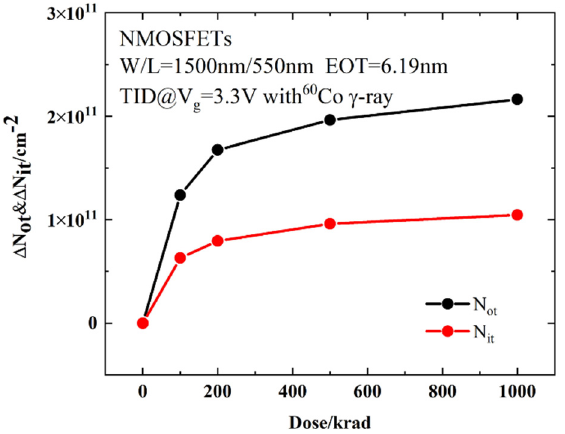
Figure 3. Δ N ot and Δ N it at different doses during radiation. Figure 3. ∆ N ot and ∆ N it at different doses during radiation.